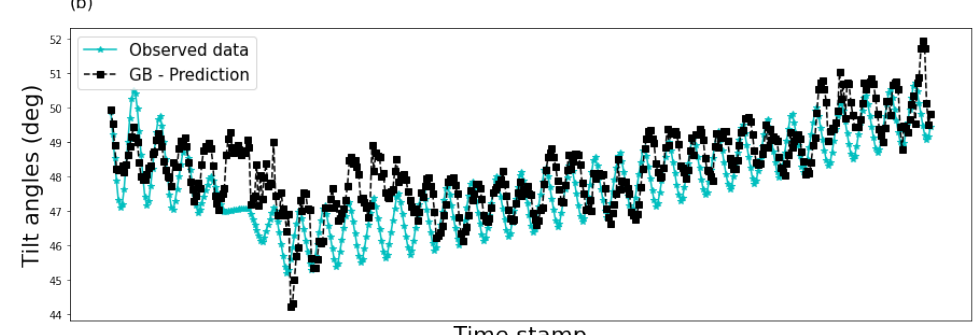
Figure 14. GB prediction results for a random selection of ( a ) 3 days and ( b ) 31 days of the ob- served dataset.